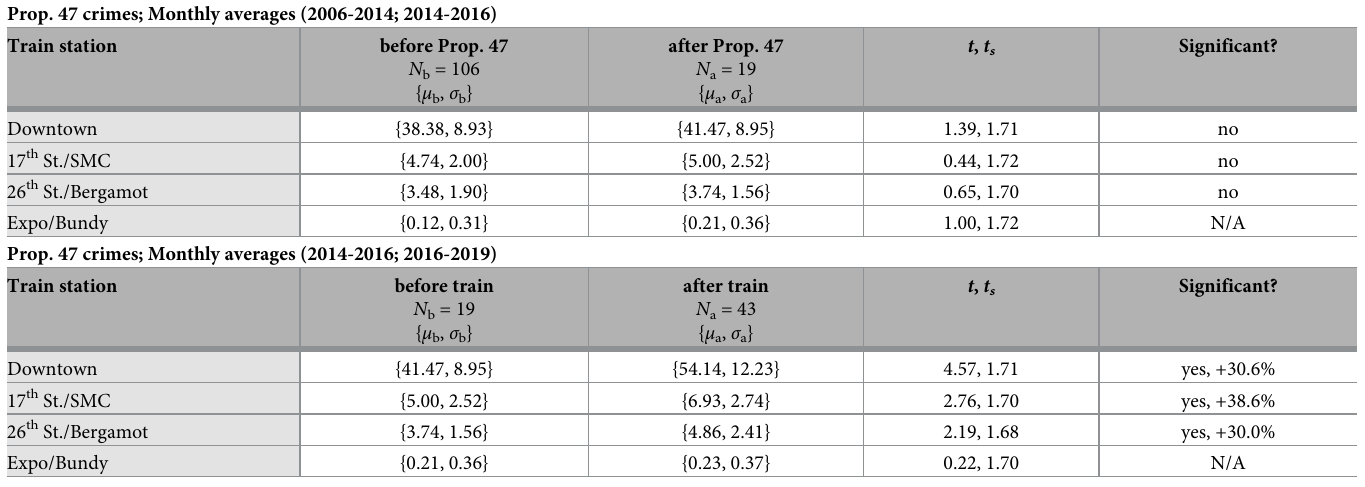
Table 5. Statistical tests on reported Prop. 47 crime in the vicinity of light rail station locations in Santa Monica, CA, during three successive time periods spanning 2006–2019. Prop. 47 crimes; Monthly averages (2006-2014;